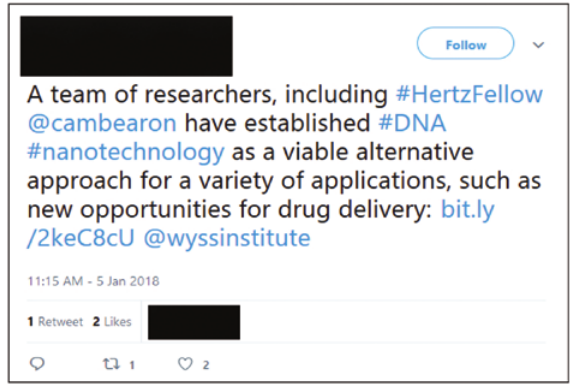
Figure 3: A sample tweet (relevant).